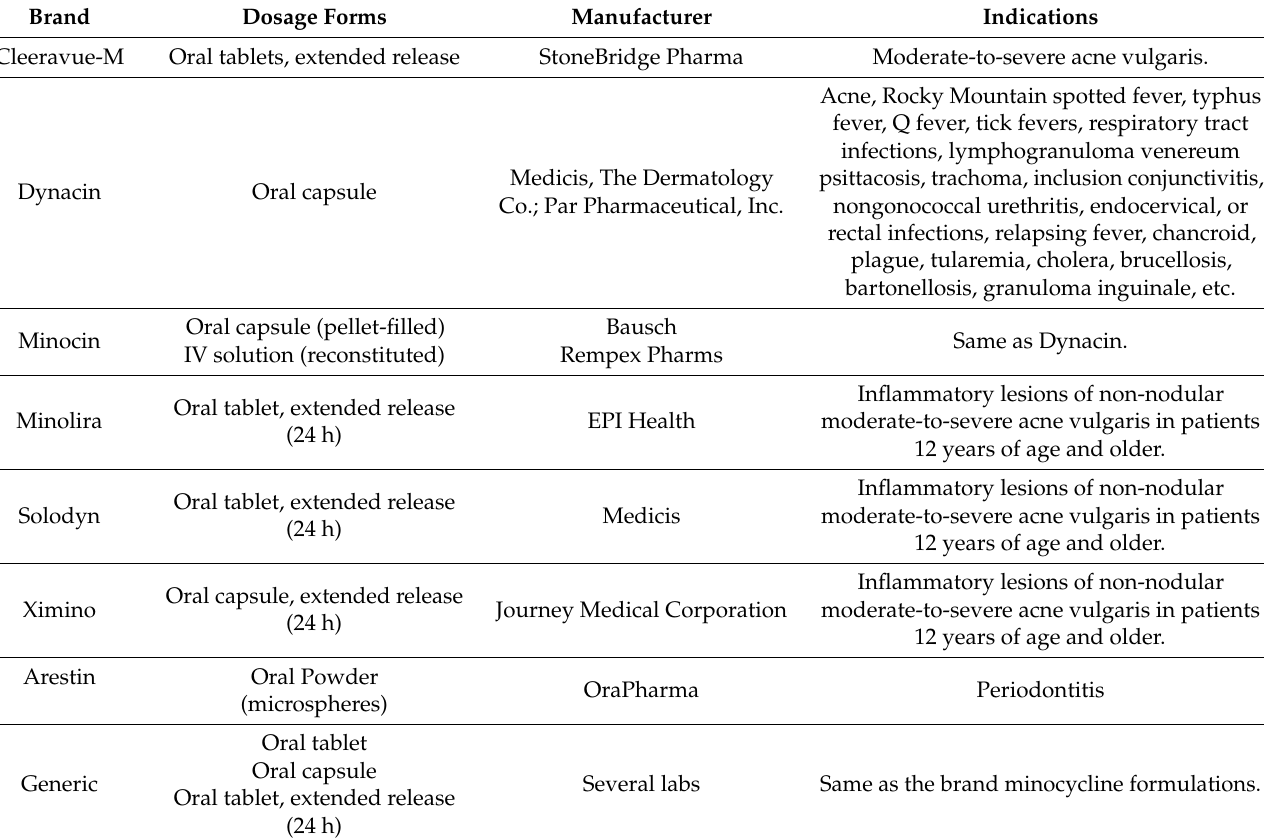
Table 1. Brands of minocycline currently approved for systemic use in the USA market